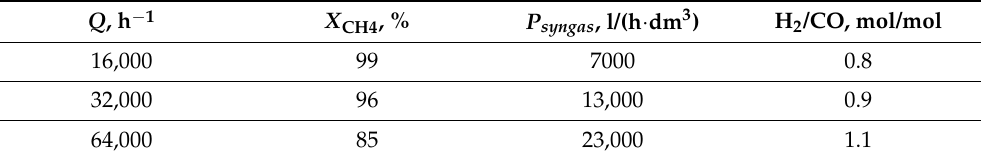
Table 5. Output parameters of the carbon dioxide and steam reforming of the off-products of the Fischer–Tropsch synthesis (Ni-Co, 780 ◦